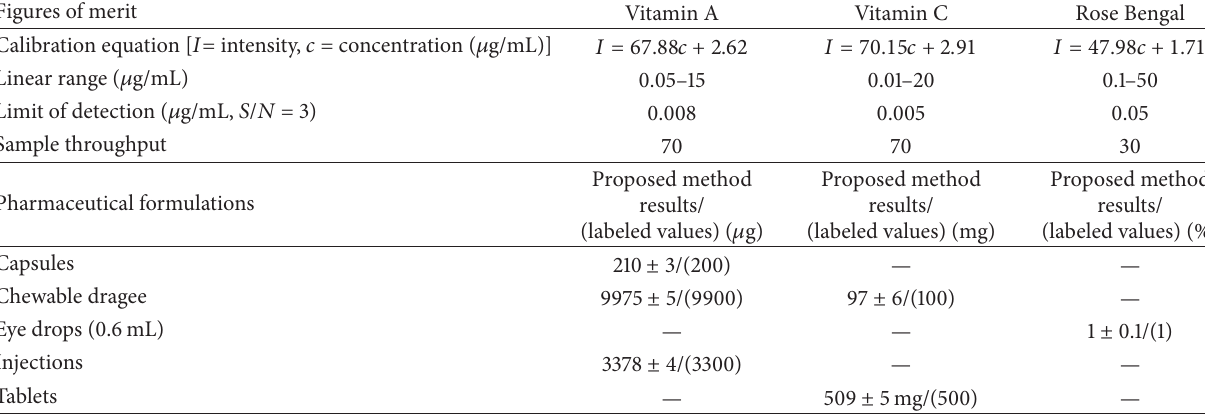
Table 2: Analytical performance and analyte determination in pharmaceuticals by the proposed method ( 𝑛 = 5 ). Figures of merit Vitamin A Vitamin C Rose Bengal Calibration equation [ 𝐼 = intensity, 𝑐 = concentration ( 𝜇 g/mL)] Linear range ( 𝜇